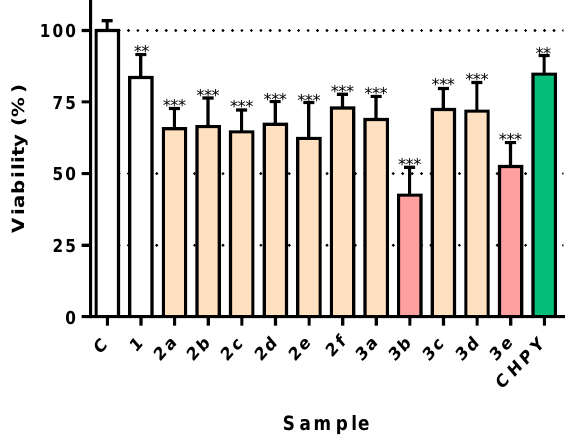
Figure 1. Viability of cells exposed to the molecules under study 2a–f and 3a–e (100 µ g / mL), medium (control), or the reference insecticide chlorpyrifos (CHPY; 100 µ g / mL). Cells were incubated for 24 h, after which viability was evaluated. ** p < 0.01; *** p < 0.001.